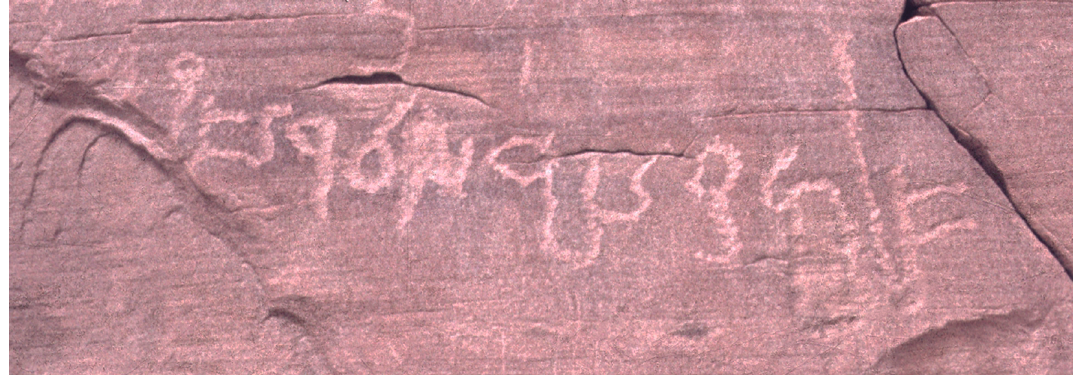
Figure 15 Nabataean inscription from Wadi Hajjaj, southeastern Sinai, of Qinw son of Awishw (see Negev 1977b, No.